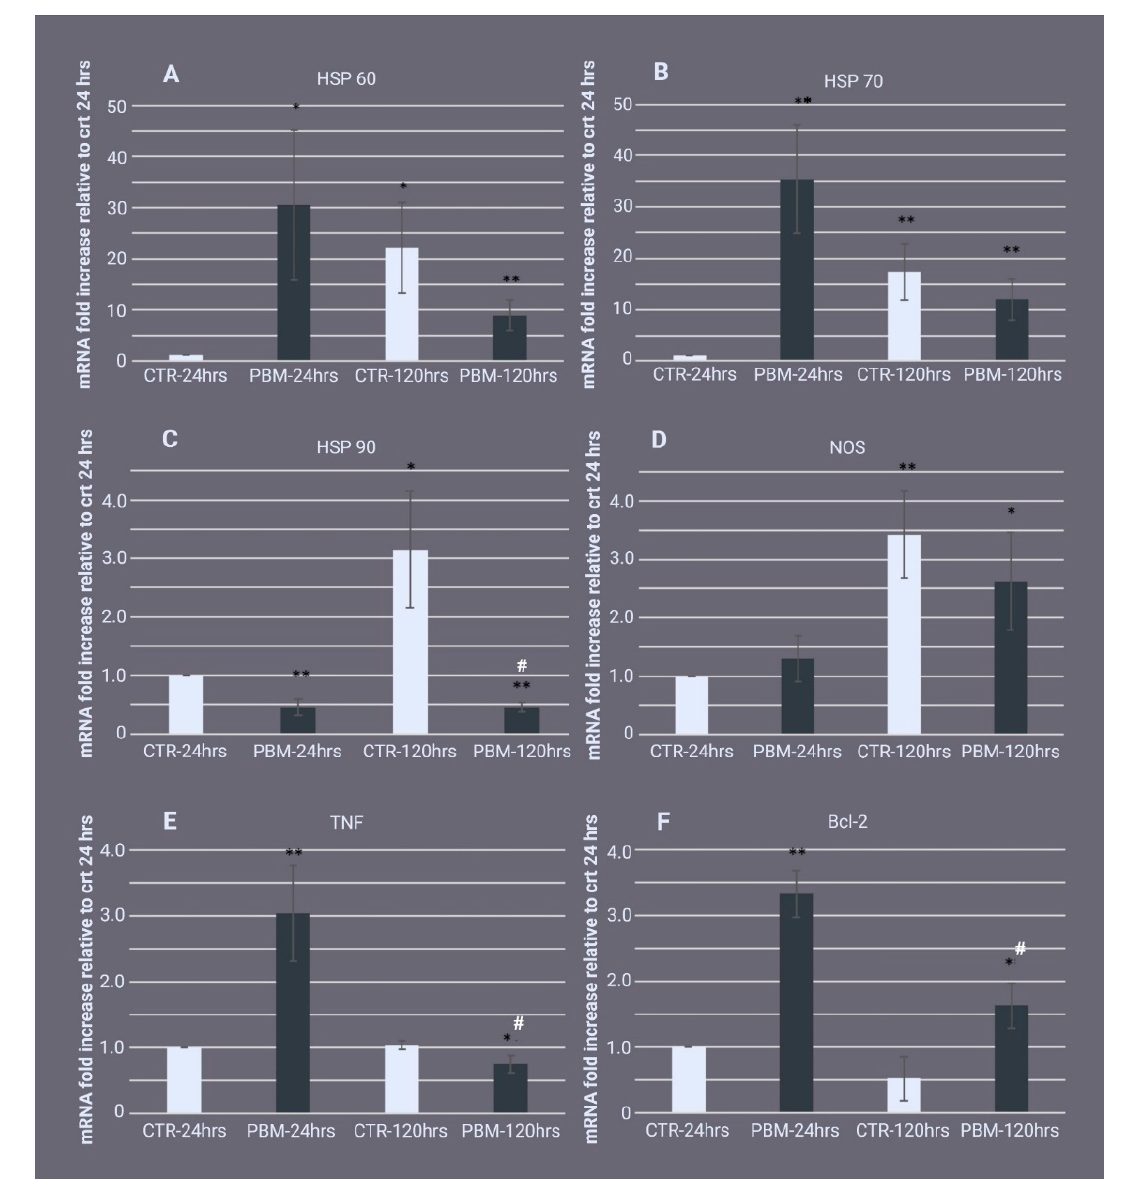
Figure 4. The effect of photo-biomodulation (PBM) on the expression of genes related to thermal stress, inflammation, and apoptosis. The real-time PCR gene expression analysis of ( A ) heat shock protein 60 (HSP60), ( B ) HSP70, ( C ) HSP90, ( D ) nitric oxide synthase (NOS), ( E ) tumour necrosis factor (TNF), and ( F ) Bcl-2 ( F ) in regenerating Chondrosia reniformis tissue 24 h (PBM-24 h) or 120 h